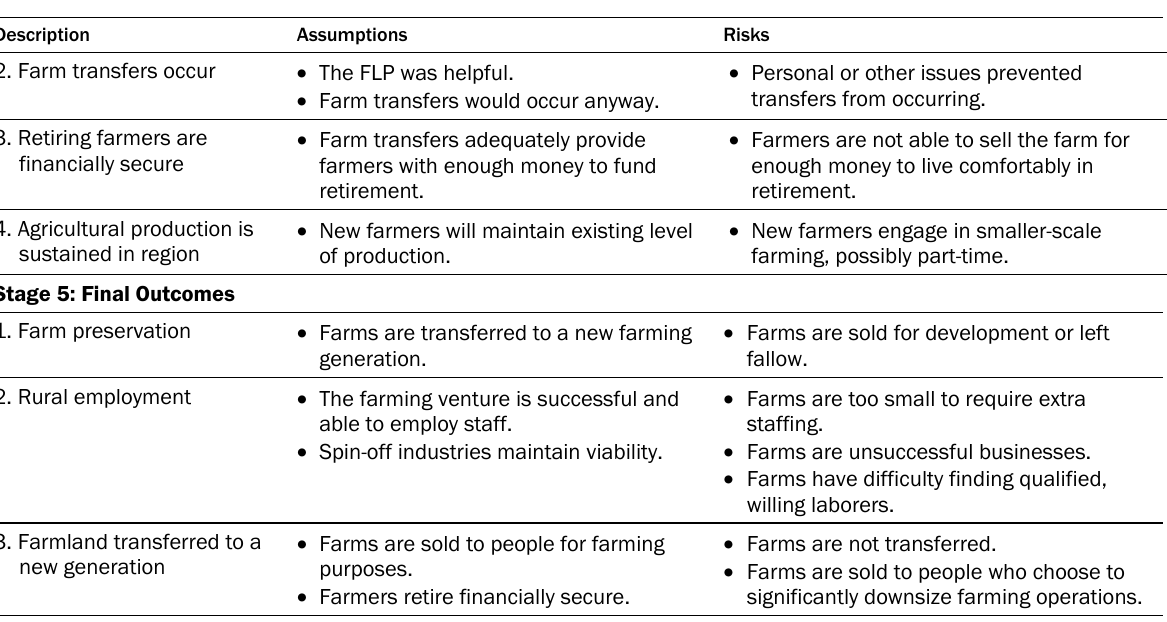
Table 3. Stated Objectives of Farm Link Programs (FLPs) in This Study